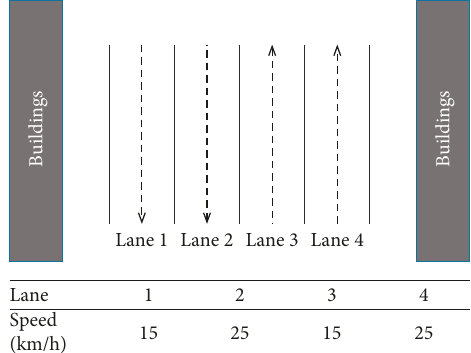
Figure 5: Vehicle speed in the 4-lane road (Area 1).